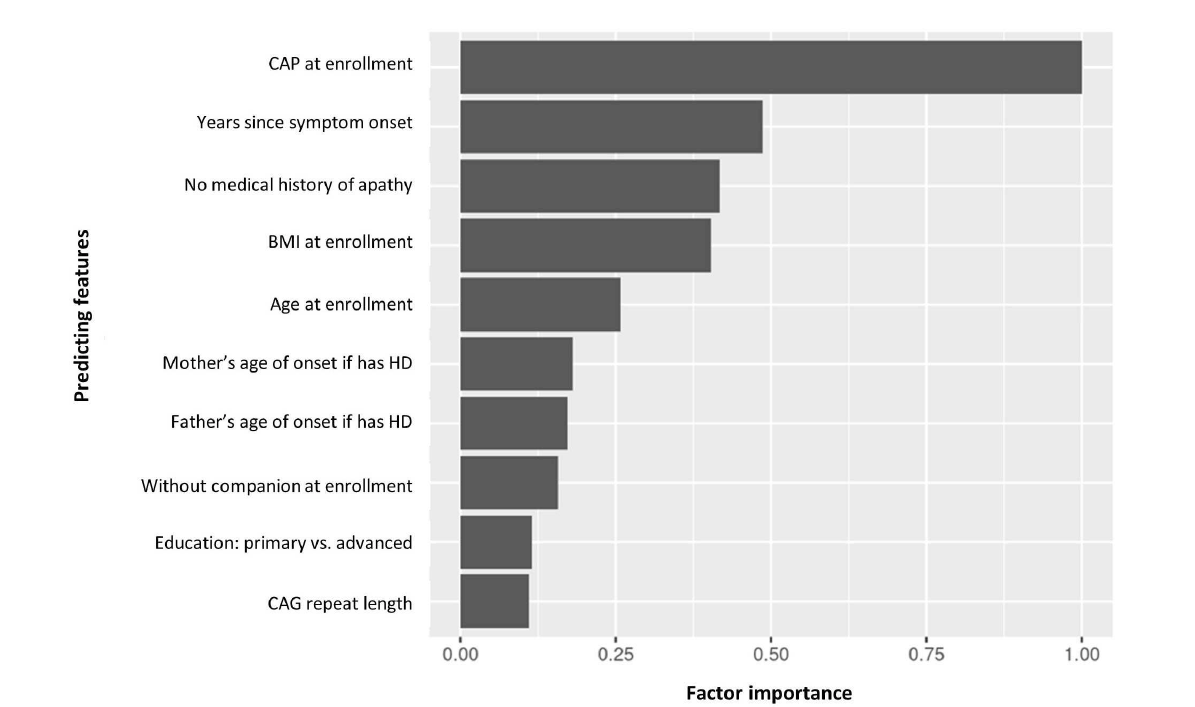
FIGURE6 Factor importance of the top 10 predicting features of manifest HD progression clusters. BMI, body mass index; CAG, cytosine adenine guanine; CAP, CAG-age product; HD, Huntington’s disease.